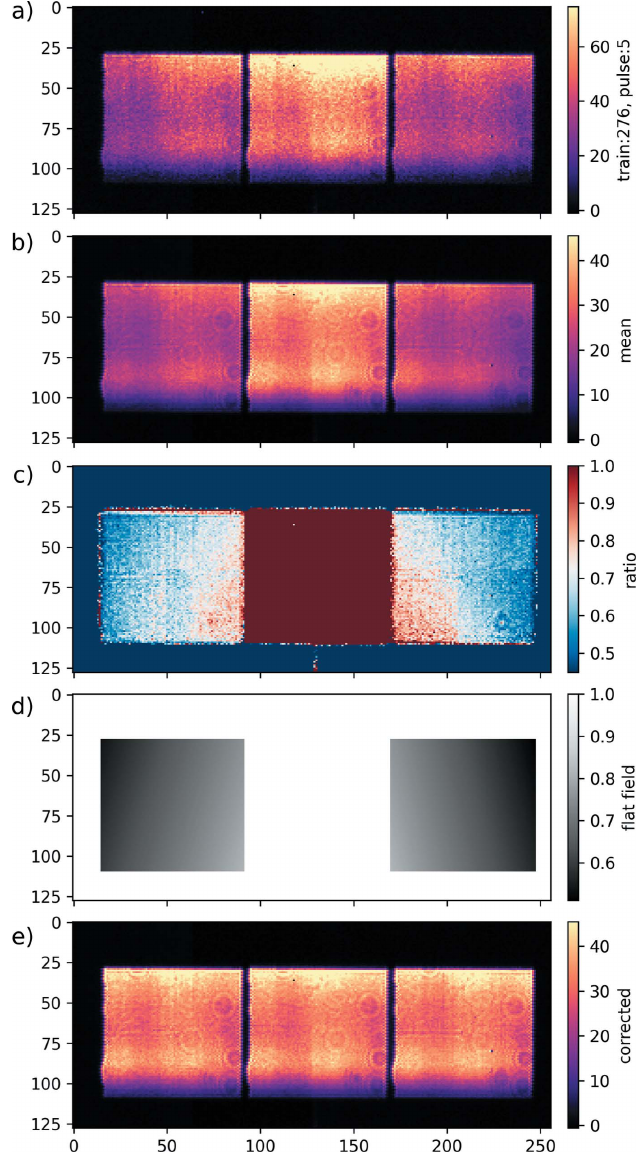
Figure 4 ( a ) Dark-corrected single-pulse image of the DSSC sensor showing the three imaged beams ( (cid:2) 1st, 0th and +1st order). ( b ) Dark-corrected average image of a single DSSC sensor showing the three imaged beams based on a 5 min-long data acquisition recording 3000 FEL trains with 15 X-ray pulses per train. ( c ) Image showing each beam normalized by the 0th order beam. ( d ) Fitted flat-field correction. ( e ) Dark-corrected and flat-field-corrected average image in a single DSSC sensor. The three imaged beams now appear as identical copies of the initial beam.